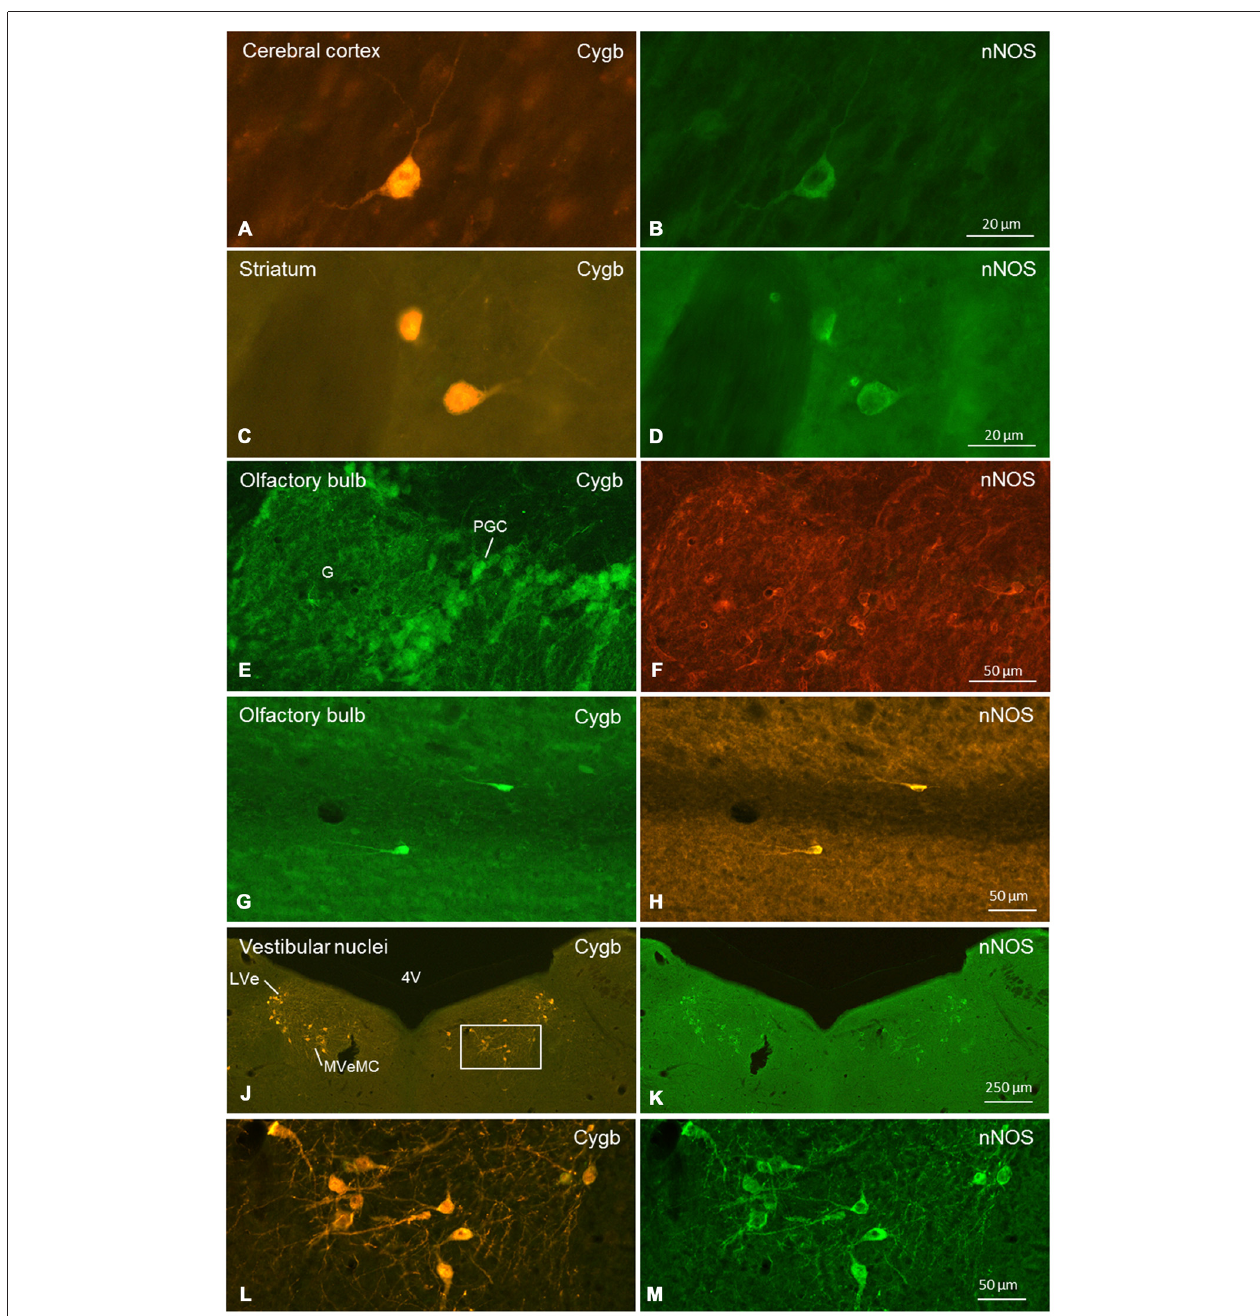
FIGURE 9 | Double-immunofluorescent labeling of cytoglobin (Cygb, left row) and (nNOS, right row) in selected regions of the mouse brain (frontal sections). Complete or partial colocalization of both substances was observed in the CCo (A,B) , striatum (C,D) , glomerular layer (E,F) and subependymal layer (G,H) of the olfactory bulb, and medial and lateral vestibular nucleus (J–M) . The boxed area in (J) is shown in higher magnification in (L) . Note that (E–H) stem from a dye-swap experiment. Abbreviations: 4V, fourth verntricle; G, glomerulus; PGC, periglomerular cells; LVe, lateral vestibular nucleus; MVeMC, medial vestibular nucleus, magnocellular